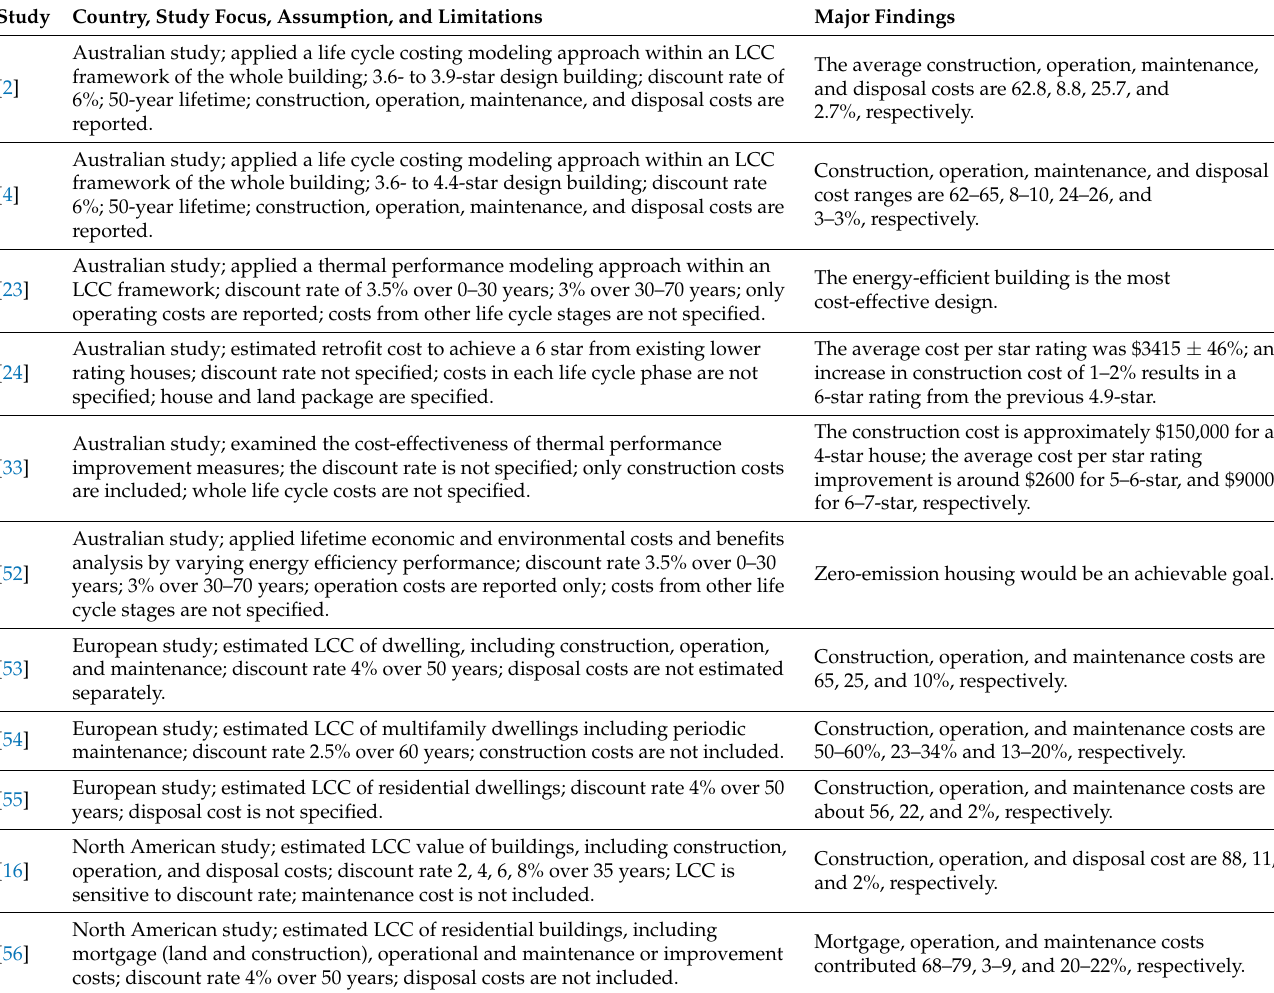
Table 2. Summary of previous cost studies on residential